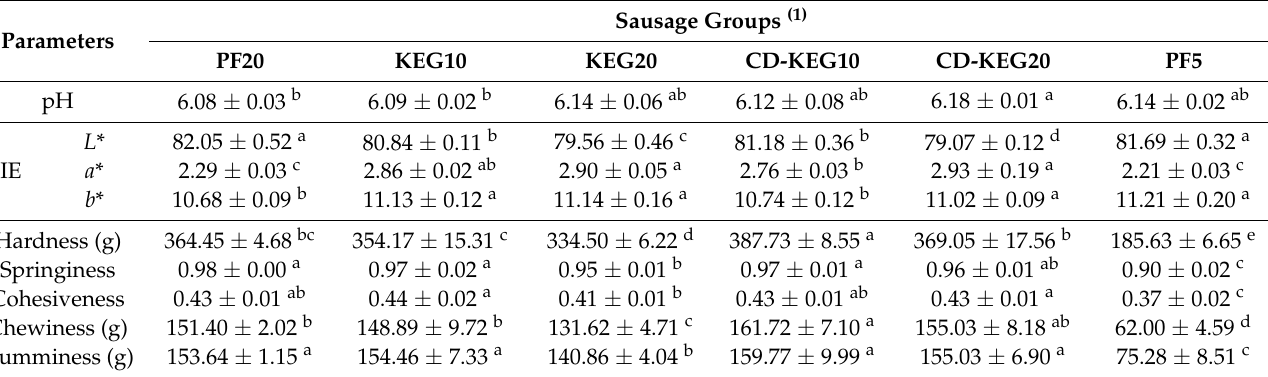
Table 2. pH, color, and texture parameters of emulsion gel-supplemented